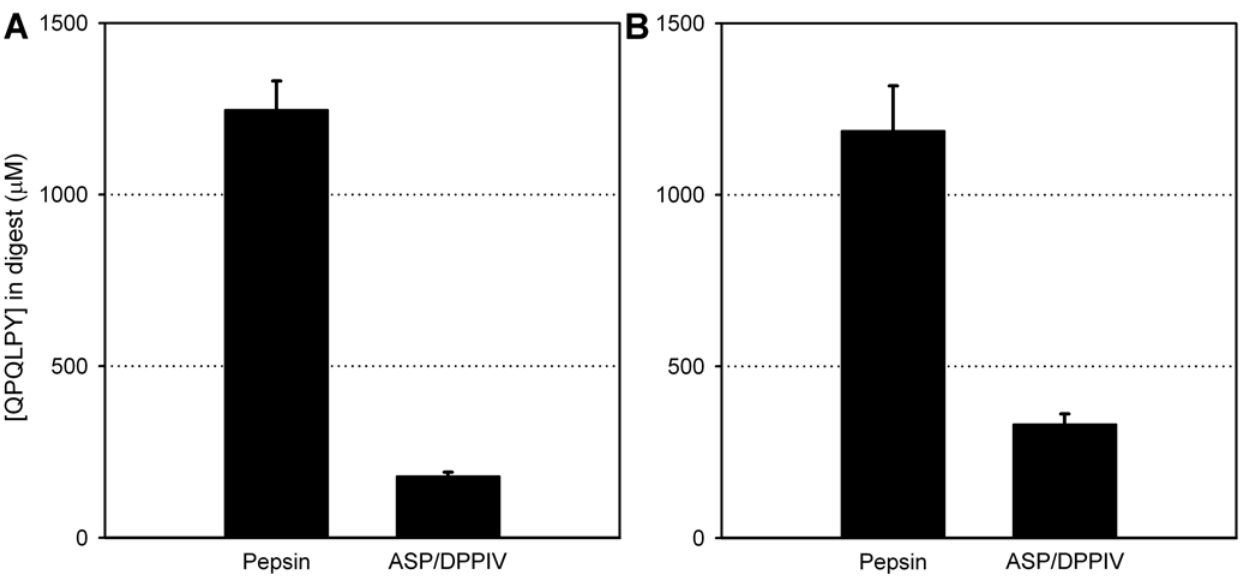
Figure 8. Gluten detoxifying activity of aspergillopepsin (ASP) and dipeptidyl peptidase IV (DPPIV) under conditions simulating gastric digestion of a meal. (A) Whole gluten powder (15 mg/ml) or (B) whole gluten powder (15 mg/ml) mixed with casein (50 mg/ml) was incubated with either 0.6 mg/ml pepsin or 0.35 mg/ml ASP and 0.7 mg/ml DPPIV at 37 u C for 60 min. The digestions were initiated in 0.03 M HCl and 3 mg/ml CaCO 3 , and every 5 min additional HCl was added. Gliadin peptides present in the digests were analyzed by competitive ELISA using the G12 monoclonal antibody, which is specific for the immunotoxic gliadin epitope QPQLPY.